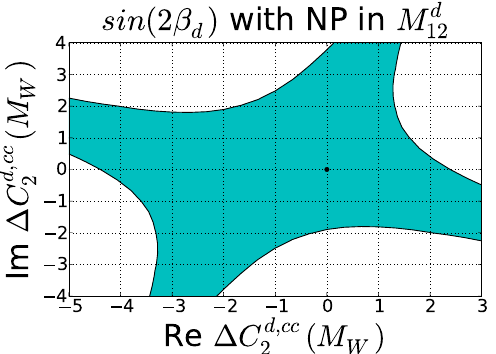
Figure 14 . Potential regions for the NP contributions in (cid:1) C d;cc ( M W ) allowed by the observable 2 sin(2 (cid:12) d ) from modi(cid:12)cations in M d through double insertions of the (cid:1) B = 1 e(cid:11)ective Hamiltonian 12 at 90% C.L. . Due to the weakness of the current bounds, penguin pollution has been neglected in the analysis. The black point corresponds to the SM value.